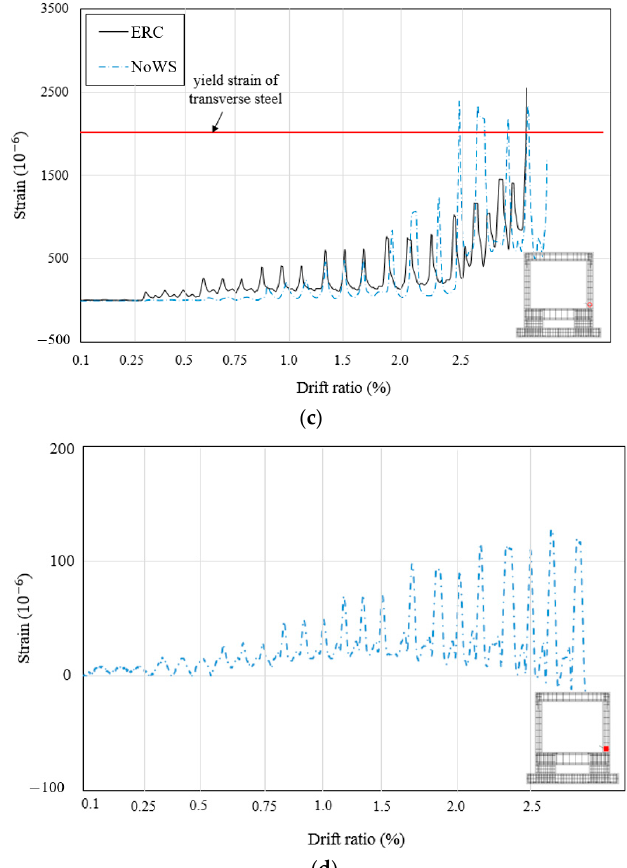
Figure 12. Strain responses of specimens: ( a ) Strain of concrete; ( b ) strain of longitudinal steel; ( c ) strain of hoop; ( d ) strain of the CFST frame.